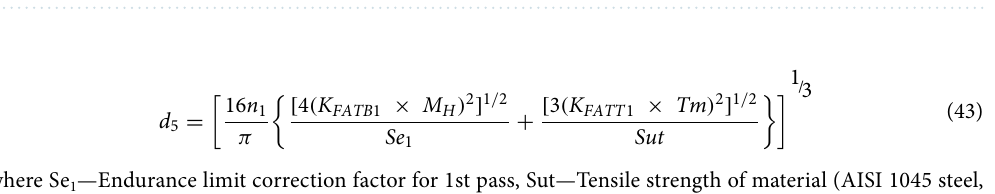
Figure 15. Bending moment diagram for the shaft